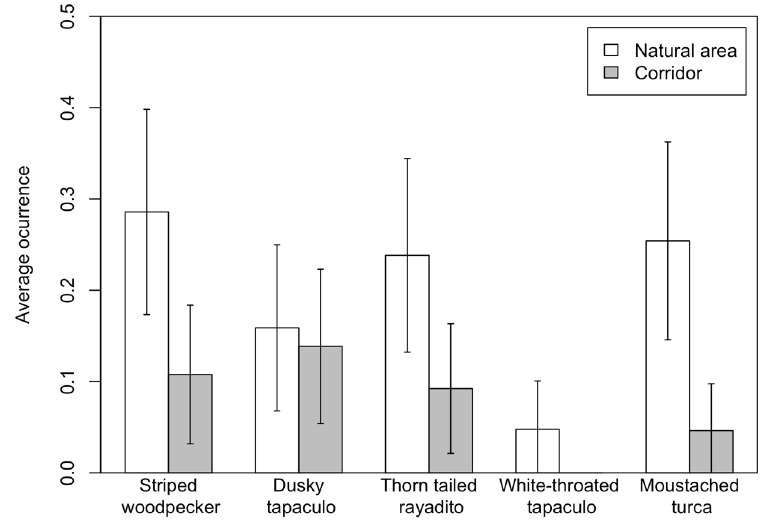
Figure 5. Average occurrence of indicator bird species in vegetation corridors within vineyards (C) and in adjacent natural areas (i.e., patches of natural vegetation near cultivated land).